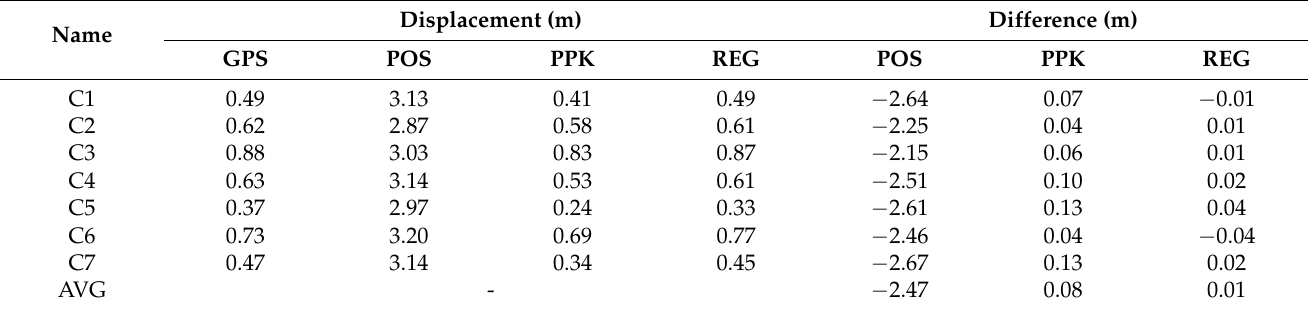
Table 3. The displacement and difference of the sprayed stones in the two sequential 3D